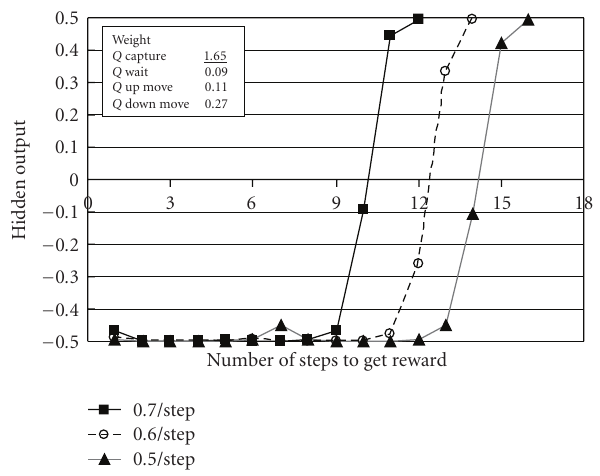
Figure 18: Output change of the 29th hidden neuron for the three